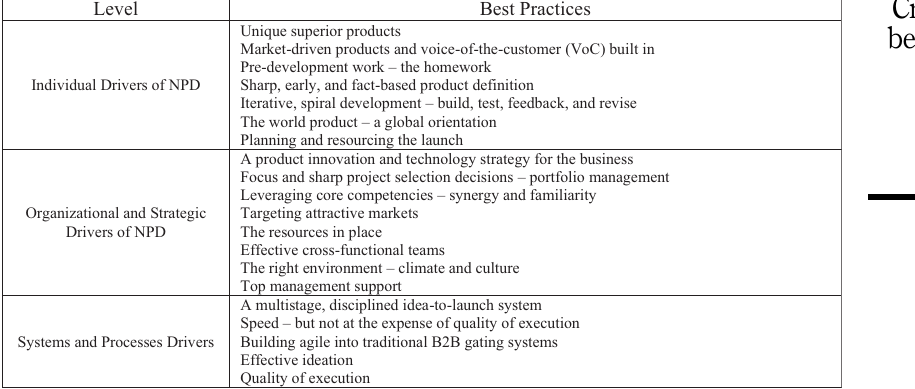
Figure 1. Drivers for NPD development